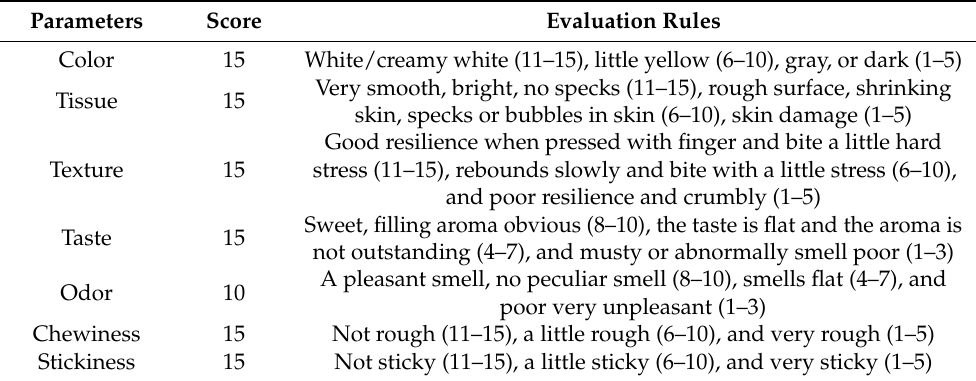
Table 1. Scoring method for sensory evaluation of steamed